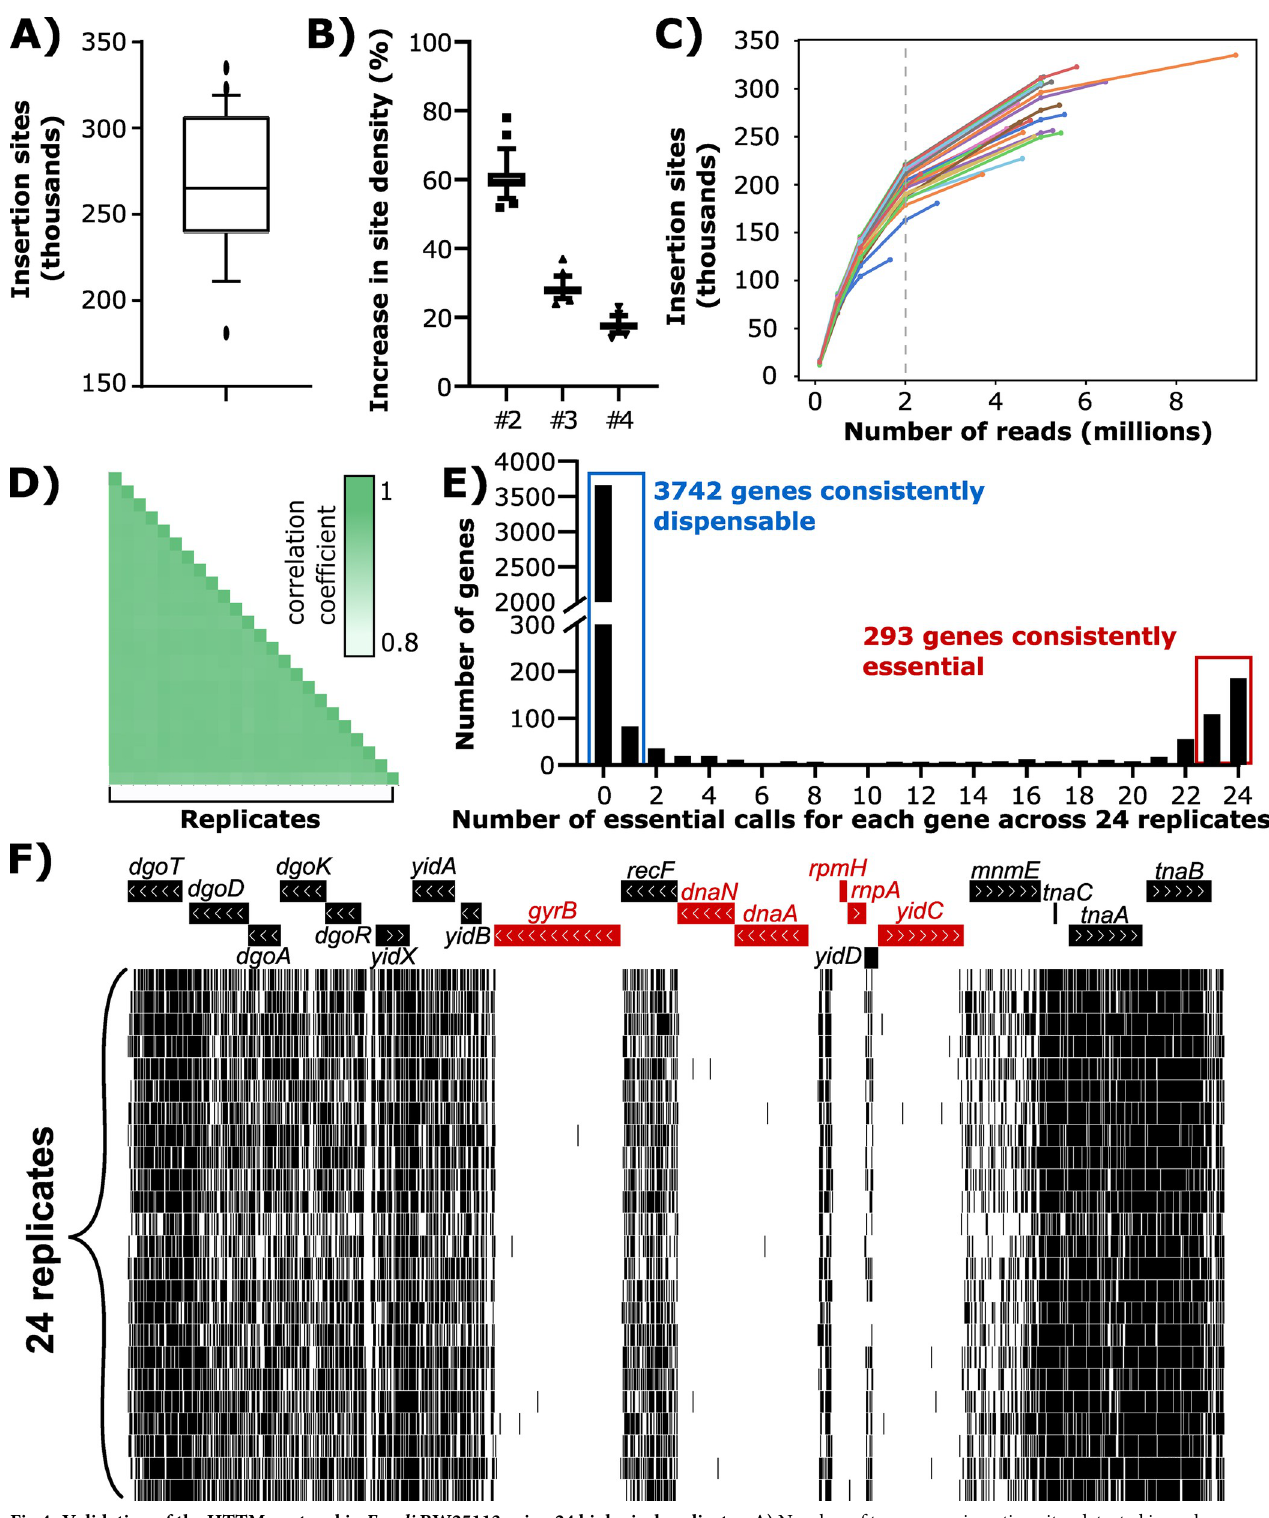
Fig 4. Validation of the HTTM protocol in E . coli BW25113 using 24 biological replicates. A) Number of transposon insertion sites detected in each replicate. Whiskers indicate 10–90 percentile. B) The average number of transposon insertion sites increases per additional PCR replicate included in the analysis. Whiskers indicate 10–90 percentile. C) Saturation curves showing the number of insertion sites as a function of the downsampling of each